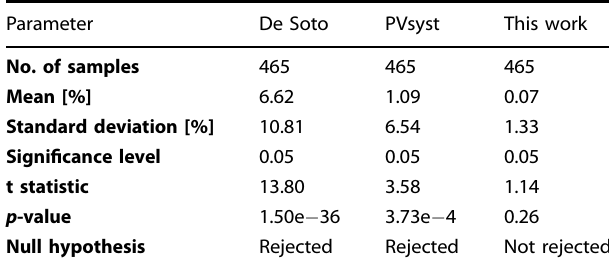
Table 2. Results of the hypothesis testing for the error metrics of each